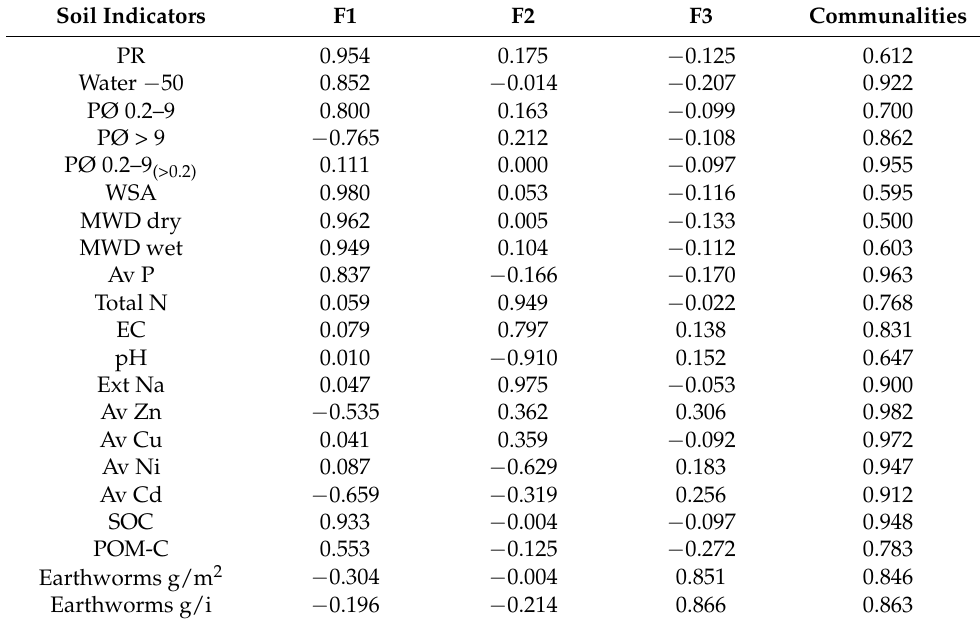
Table 5. Proportion of variance explained using varimax rotation for each of the retained factors and communalities for the selected soil properties for the 0–15 cm depth.